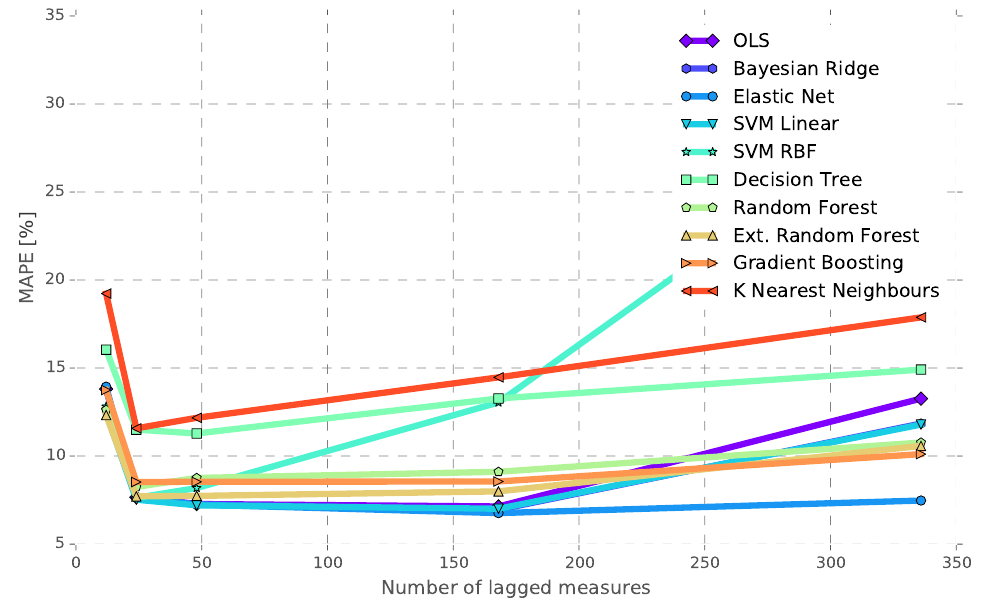
Figure 8. MAPE score for different number of lagged loads for power Network